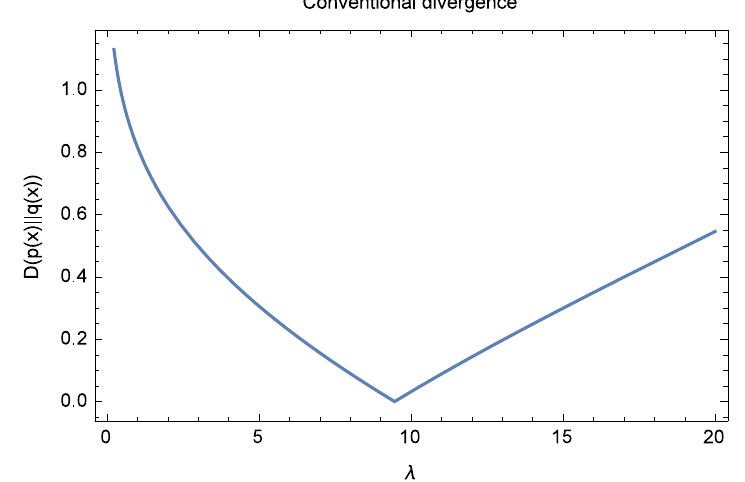
Figure 1. The divergence between the Exponential-density and the Pareto-density for a fixed Pareto scale parameter, x 0 “ 0.01.